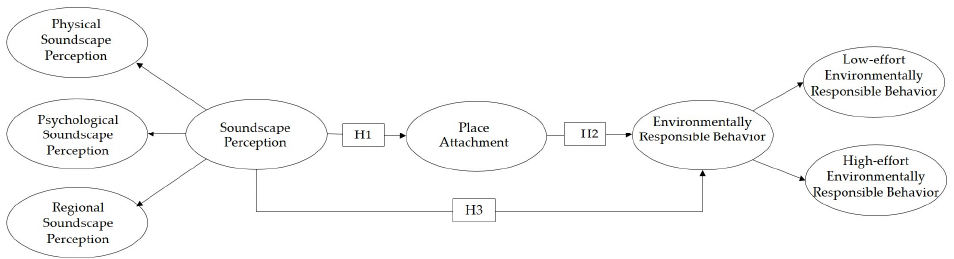
Figure 1. The theoretical framework.